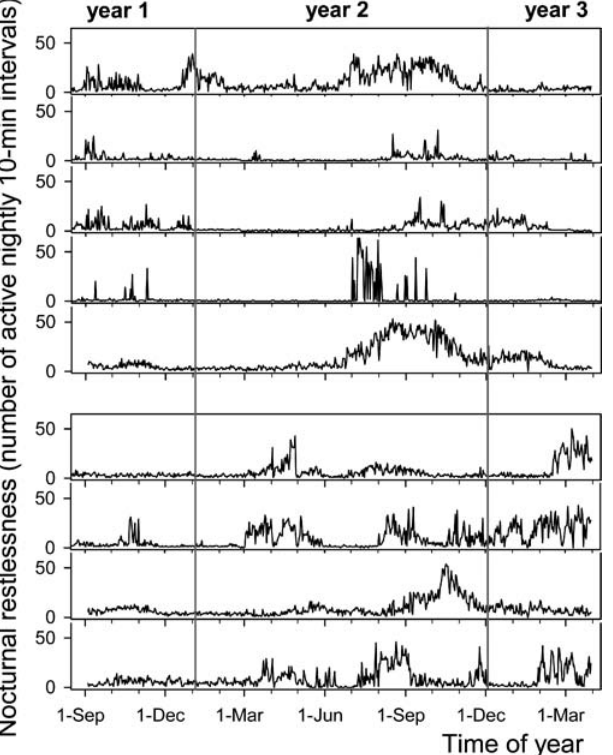
Figure 1. Nocturnal Activity under Constant Photoperiod (Light/Dark 12.25:11.75 h) Activity of five African stonechat males (upper panel) and four females (lower panel) recorded continuously in individual registration cages recorded for 1.5 years. Curves show nocturnal activity (Zugunruhe) as the number of 10-min intervals during which the birds were active at night. Since the birds received no temporal cues, the repeated, spontaneous outburst of nocturnal activity indicates an underlying endogenous component. Vertical gray bars indicate years. DOI: 10.1371/journal.pbio.0040110.g001